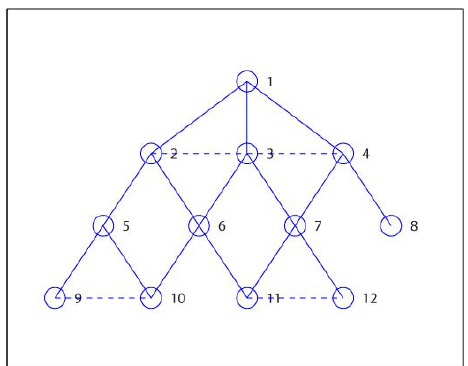
Figure 3. Layers for the given example.